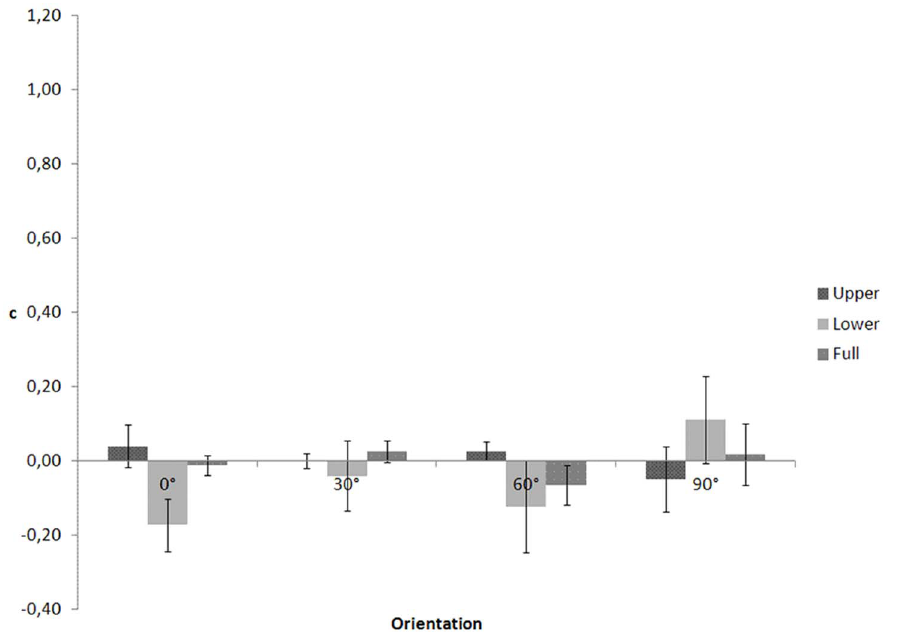
Fig. 8. c as a function of visible body part and figure orientation for the hand walking action in Experiment 4.